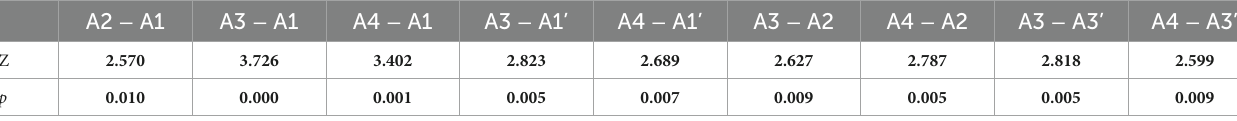
TABLE 11 Wilcoxon ranked sign test for the fixation count (only for p < 0.05).